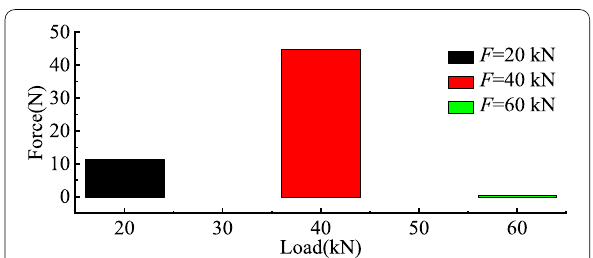
Figure 30 Collision force between roller 7 and cam ring under three loads